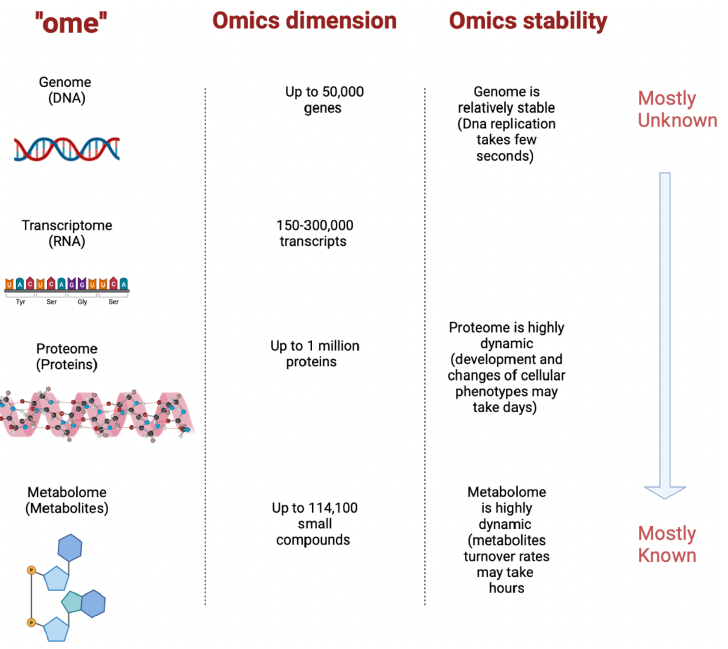
Figure 1. Metabolomic analysis advantages over other omics